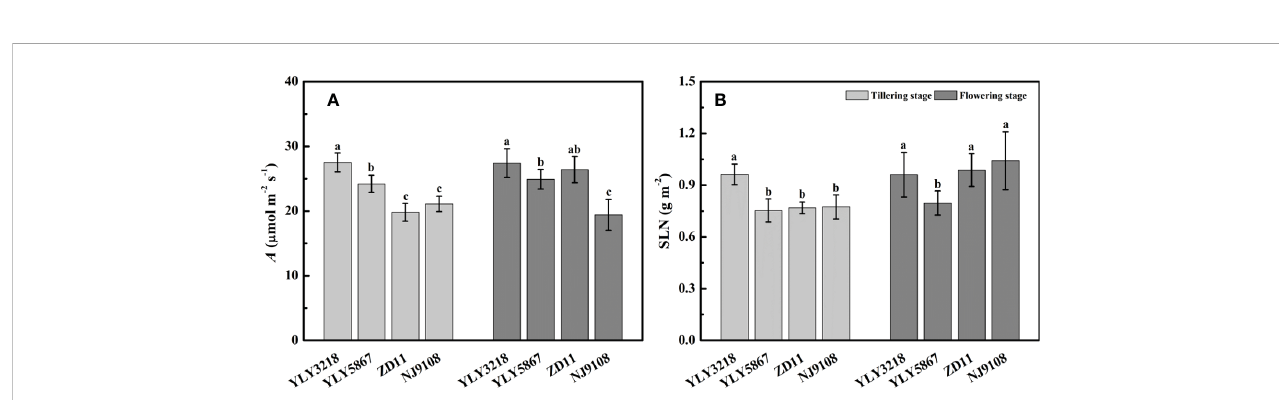
FIGURE 2 Net photosynthesis rate under saturated irradiance ( A sat ) (A) and nitrogen concentration per leaf area (SLN) (B) of the latest fully expanded leaves for different rice cultivars during tillering and fl owering stage. Different letters mean signi fi cant differences ( P < 0.05) among rice cultivars during the same growth